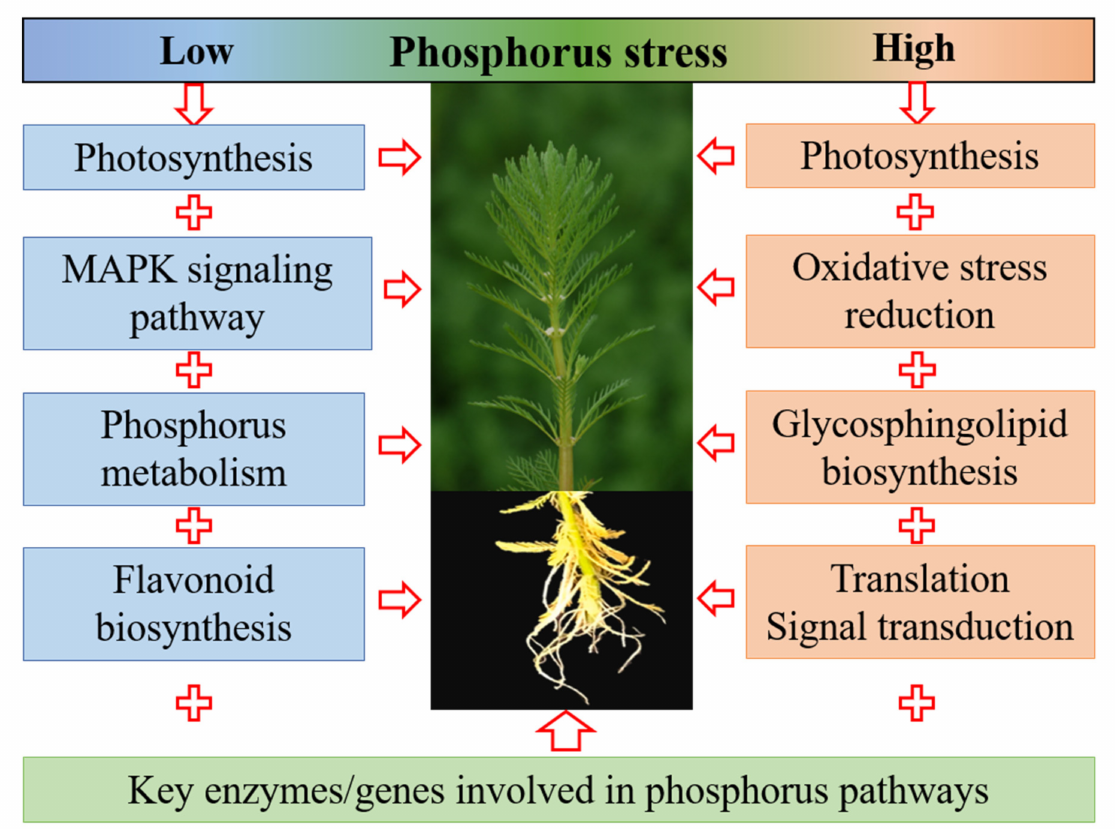
Figure 7. Graphic model of genetic regulatory network in Myriophyllum aquaticum responding to different phosphorus